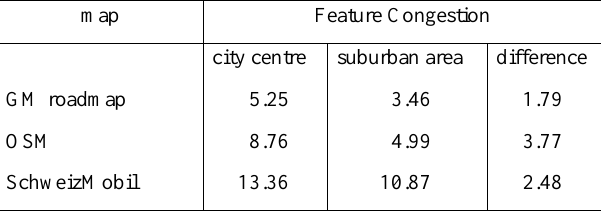
Table 1. Visual complexity measured with Feature Congestion for maps of the city center and suburban area from various